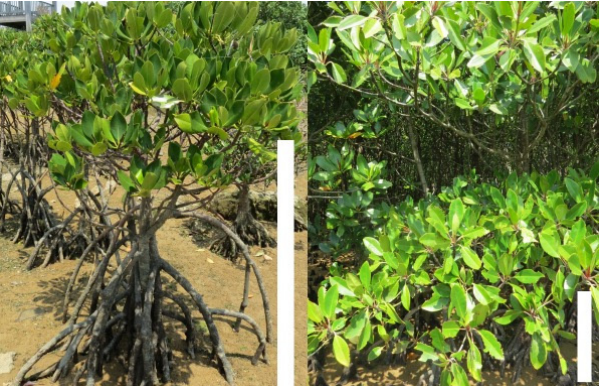
Figure 1. R. stylosa trees in the oceanside ( left ), and the riverside ( right ). Bars represent about one meter (m). Oceanside trees appear shorter (1–1.5 m) and the riverside trees grow to be as tall as 3–3.5 m.